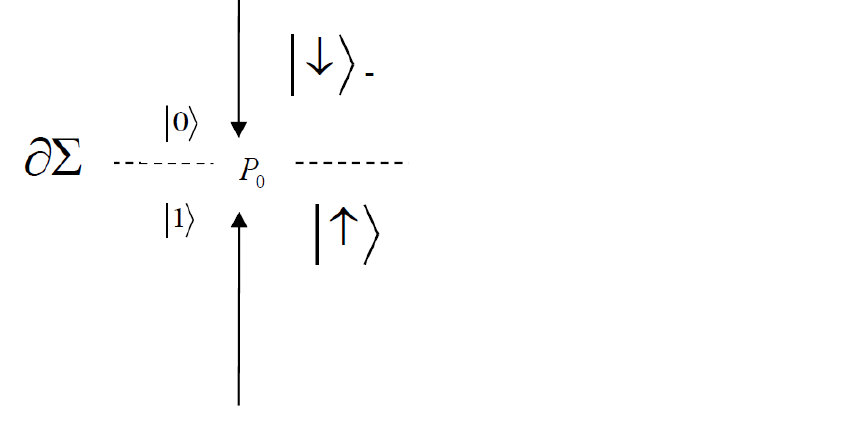
Figure 1. A Double Puncture: A pair of spin edges “up” |↑(cid:105) and “down” |↓(cid:105) pierce the boundary ∂ Σ at the same point P 0 simultaneously and the pixel encodes both bits | 0 (cid:105) and | 1 (cid:105) . However, LQG describes spin networks as the quantum states | j , m (cid:105) (the eigenstate of angular momentum in the spherical representation) of a discrete geometry of the bulk, that is, the spin network’s edges can puncture the boundary surface only from